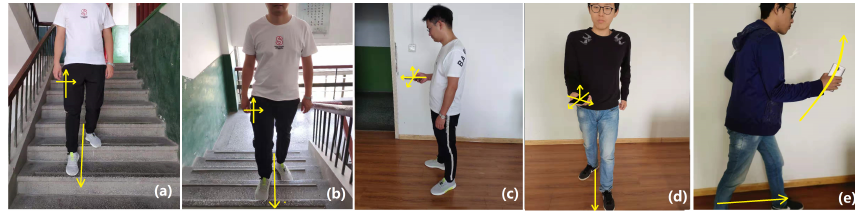
Figure 19. Real-time recognition test of comprehensive pedestrian activities.( a ) is downstairs; ( b ) is upstairs; ( c ) is standing; ( d ) is walking; ( e ) is jogging.